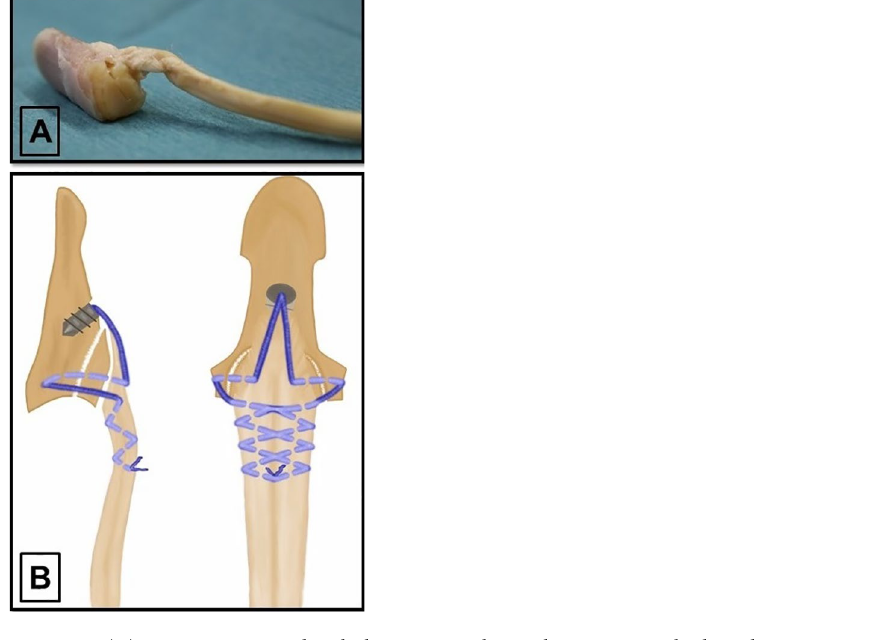
Figure 1. ( A ) Specimen repaired with the suture anchor technique. Articular line alignment is visualized. ( B ) Illustration of the suture anchor technique depicting implant position, as well as the pattern of suture placement within the distal phalanx, the bony avulsion fragment and the tendon.